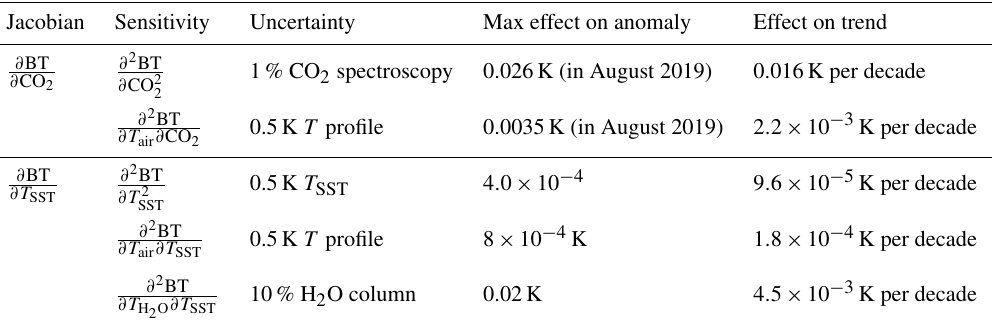
Table 4. Anomaly and trend error estimates for CO 2 and SST due to uncertainties in BT Jacobians via their second derivatives with respect to possible ERA-I uncertainties. As noted, the maximum effect on the CO 2 anomalies would be at the time of the largest anomaly, which is at the end of our time series in August 2019. See the text for